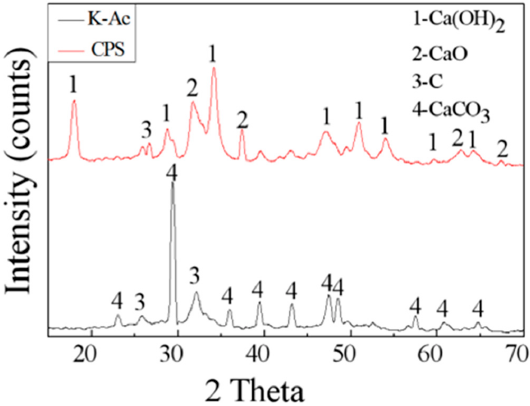
Figure 5. XRD spectra of as-prepared samples, CPS and K-Ac.